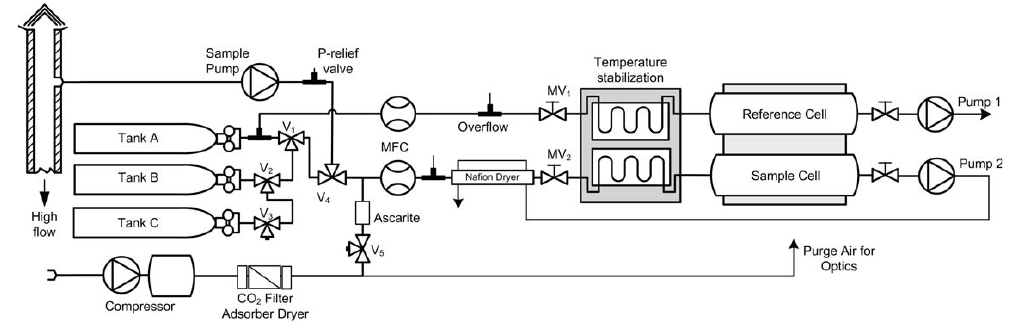
Fig. 1. Sampling setup of the QCLAS. V i and MV i are solenoid- and manual-valves, MFC-mass flow controller and Tank A, B, C are the calibration gases (see text for more